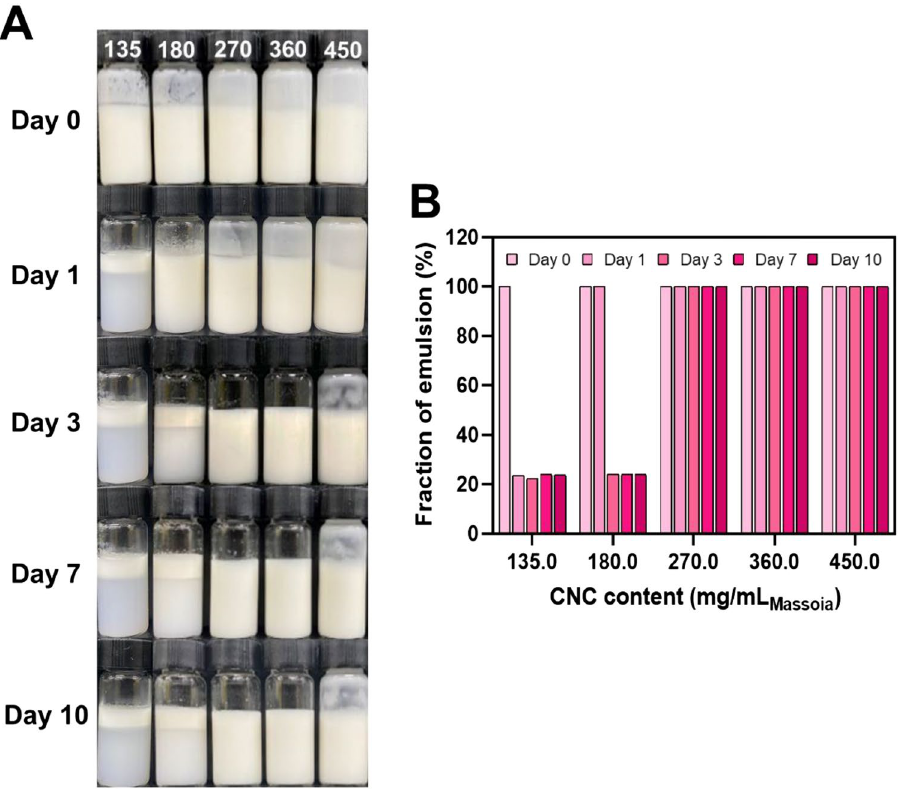
Figure 1. Phase separation of CNC/massoia PE solutions at different CNC content and storage time. ( A ) Digital images of PE solution and ( B ) the fraction of emulsion stored for 10